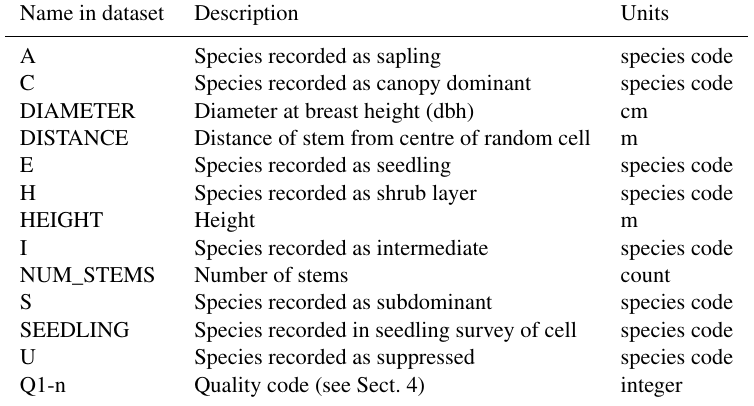
Table 6. Woodland vegetation